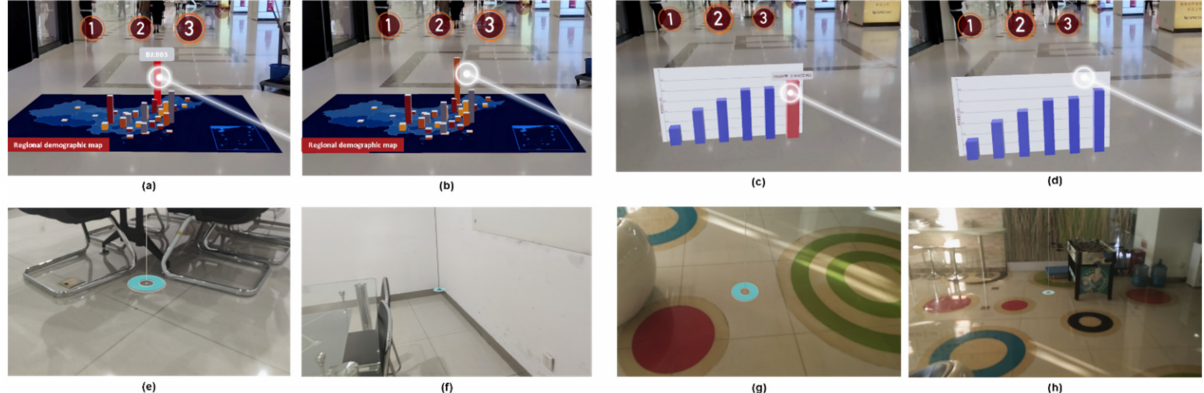
Figure 5. GIS operations based on quaternions for spatially oriented data: ( a ) 3D map spatial query; ( b ) 3D map spatial query (not queried); ( c ) 2D map spatial query; ( d ) 2D map spatial query (not queried); ( e ) Arbitrary plane recognition and extraction; ( f ) Arbitrary plane recognition and extraction (long-range); ( g ) Identification and extraction of any plane of complex office areas; ( h ) Identification and extraction of any plane in complex office areas